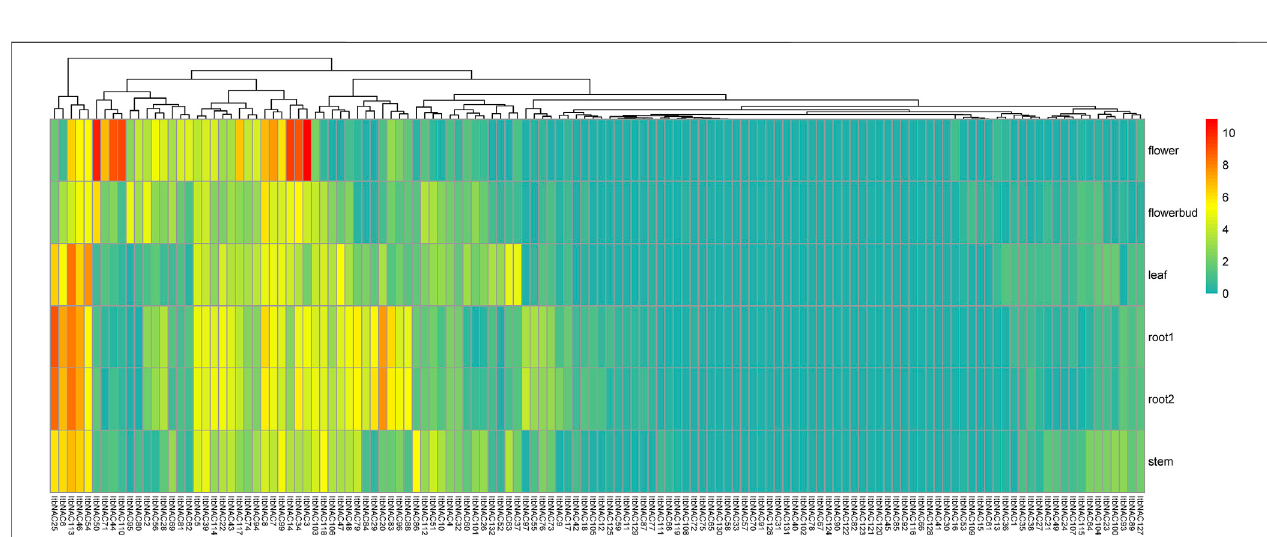
FIGURE 7 | Expression patterns of ItbNAC genes in fi ve tissues ( fl owers, fl ower buds, leaves, roots and stems) in the wild sweet potato Ipomoea triloba. The transcript abundance in different tissues was examined using RNA-Seq gene expression data. Expression pro fi les via a heat map were calculated from the log2 (FPKM+1) value, and shown as a blue-yellow-red gradient by using the heat map package in R version 3.4.0.